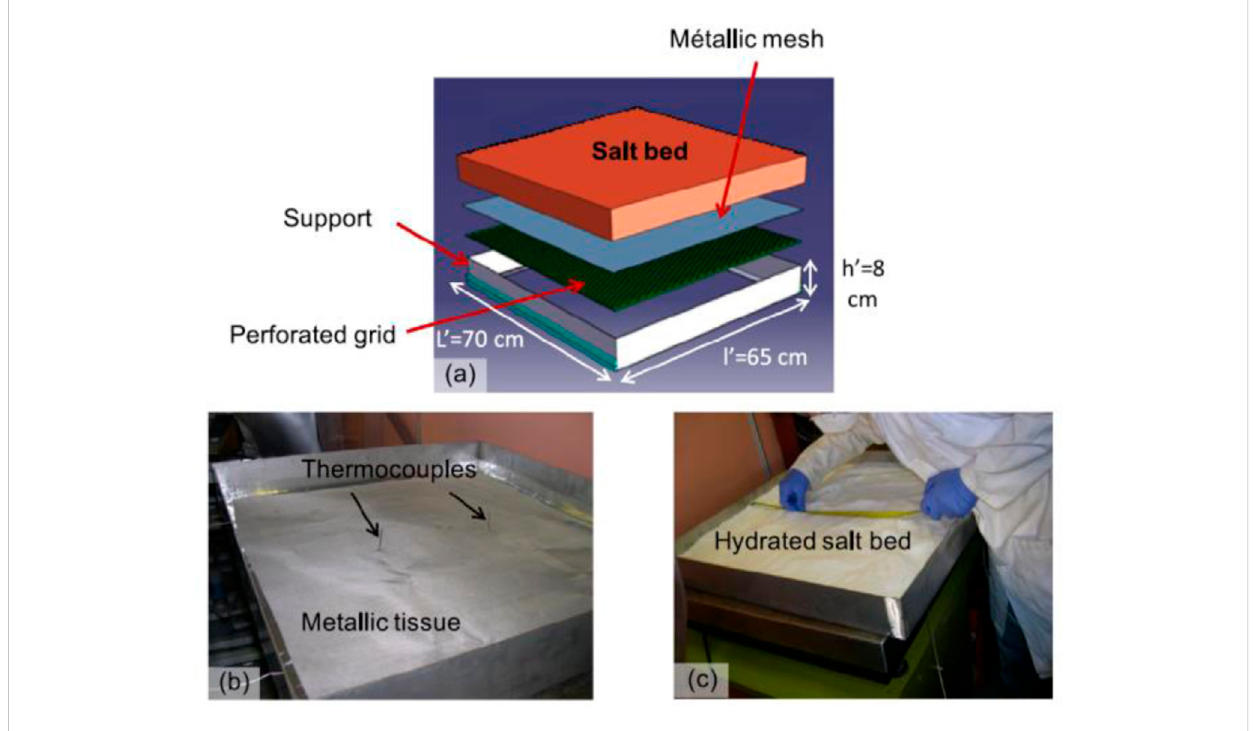
FIGURE 3 Schematic and photographic view of a module of the prototype (Michel et al., 2014). License Number: 5526331096176.